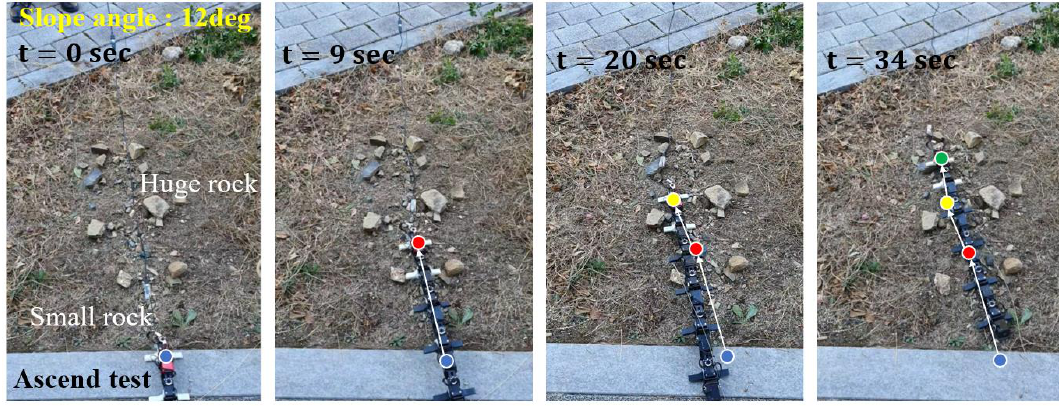
Figure 21. Performance of the ascending motion with the DAM in the branches and gravel environment.